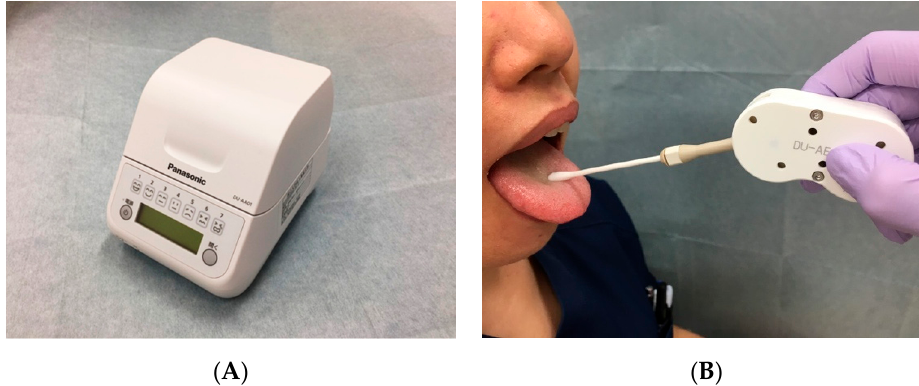
Figure 2. Bacteria detection apparatus (Panasonic Healthcare, Tokyo, Japan). ( A ) The bacteria detection apparatus. ( B ) Sample collection from the tongue.